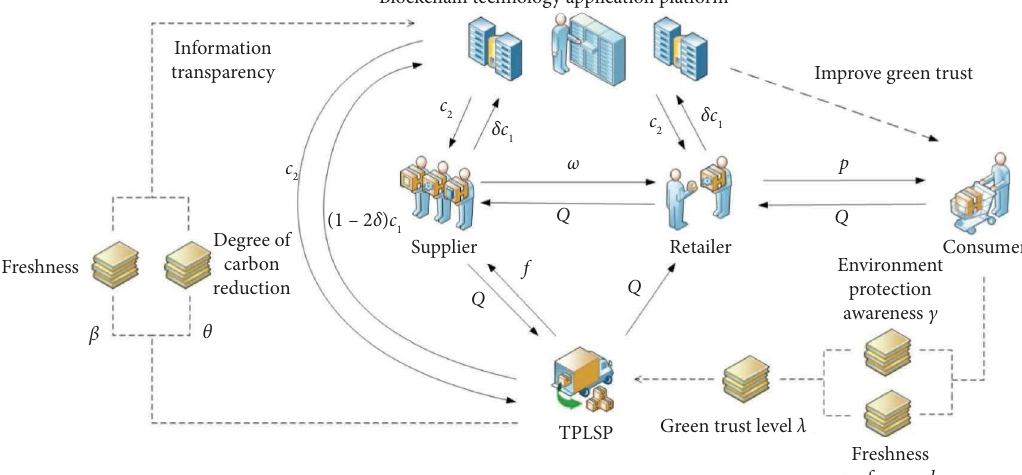
Figure 1: Operation model of fresh agricultural product supply chain based on blockchain